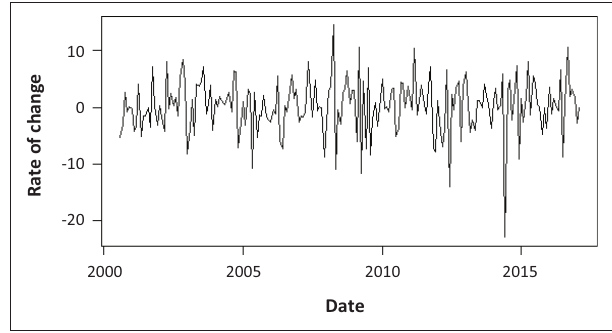
FIGURE 14: Kenya – Movement of the rate of change in reserves-to-M1 ratio.